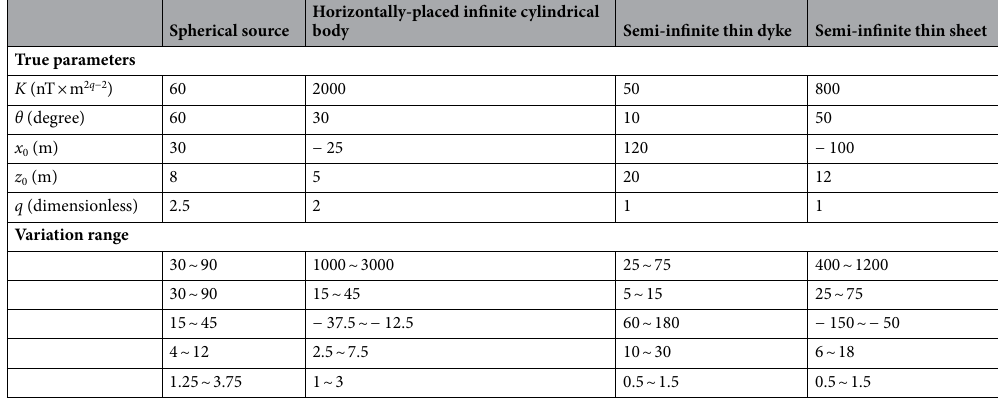
Table 2. True model parameters of the multi-source model. Parameter variation ranges are also